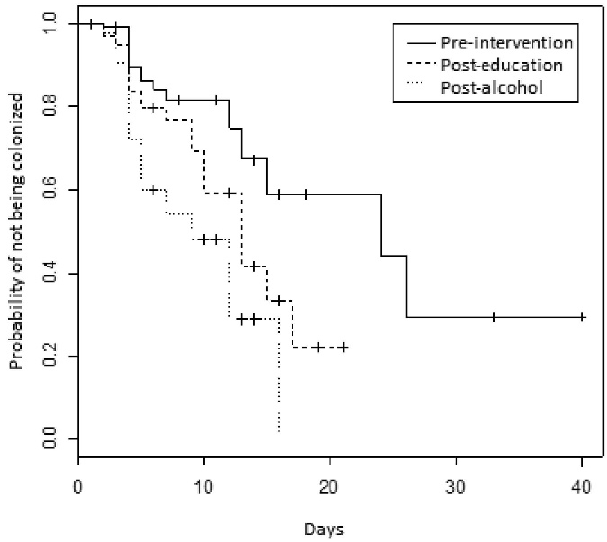
Figure 1 - Kaplan-Meier curves indicating the probability of not becoming colonized by carbapenem-resistant P. aeruginosa and/ or multiresistant Acinetobacter spp. during each of the three study periods. Neurology Intensive Care Unit, Hospital